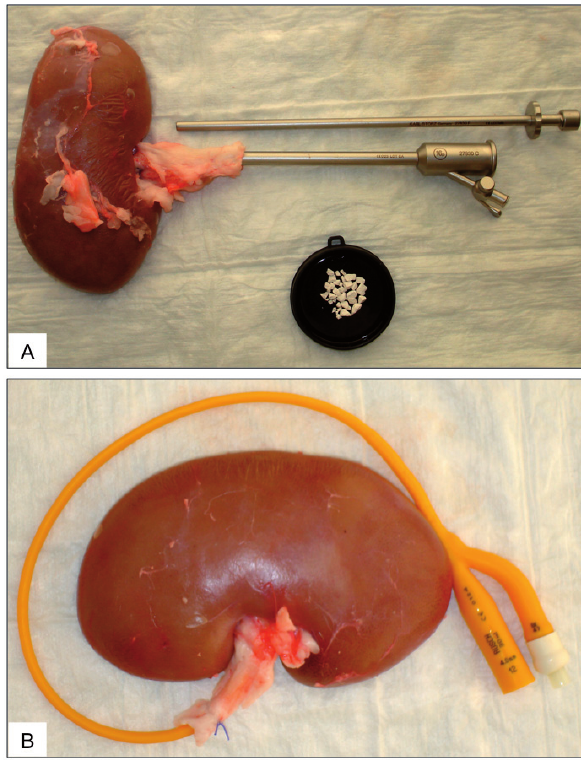
Figure 2 - Placement of artificial calculi into the renal pelvis (A) and catheterized renal pelvis for saline or dye irrigation